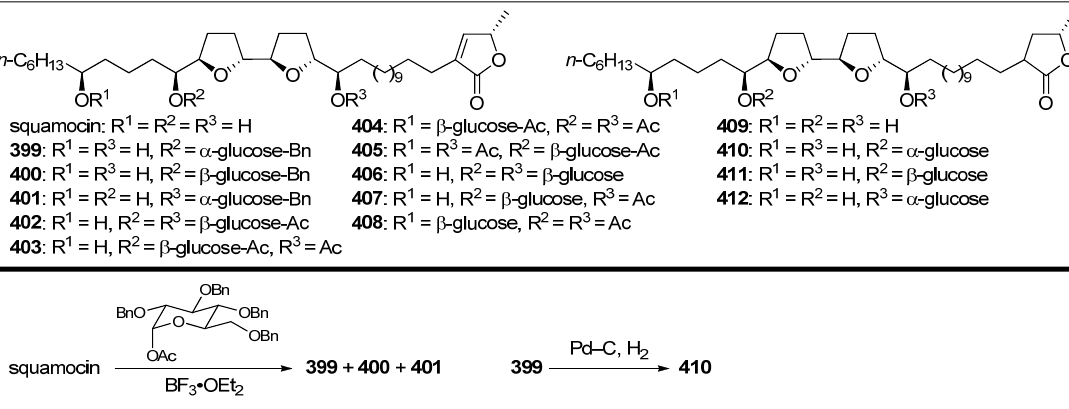
Table 30. Cytotoxic activity of glycosyl analogues of squamocin by Figadère’s group. EC ( μ M) EC ( μ M) 50 50 Compounds Compounds KB a VERO b L1210 c KB a VERO b L1210 c squamocin 1.6 × 10 − 5 1.6 × 10 − 2 < 4.0 × 10 − 4 408 1.1 × 10 − 2 3.4 × 10 − 1 1.7 × 10 − 2 399 4.3 × 10 − 1 8.7 × 10 − 1 nt 409 2.4 × 10 − 4 1.6 × 10 − 2 < 2.5 × 10 − 4 400 nt nt 5.0 × 10 − 2 410 1.9 × 10 − 3 6.0 × 10 − 1 1.0 × 10 − 2 404 9.6 × 10 − 4 2.0 × 10 − 2 3.0 × 10 − 1 411 nt nt 8.0 × 10 − 2 406 1.05 1.05 10 vinblastine 1.2 × 10 − 3 < 3.7 nt 407 3.6 × 10 − 1 1.21 50 a human epidermoid carcinoma cells; b african green monkey kidney epithelial cells; c mouse lymphocytic leukemia